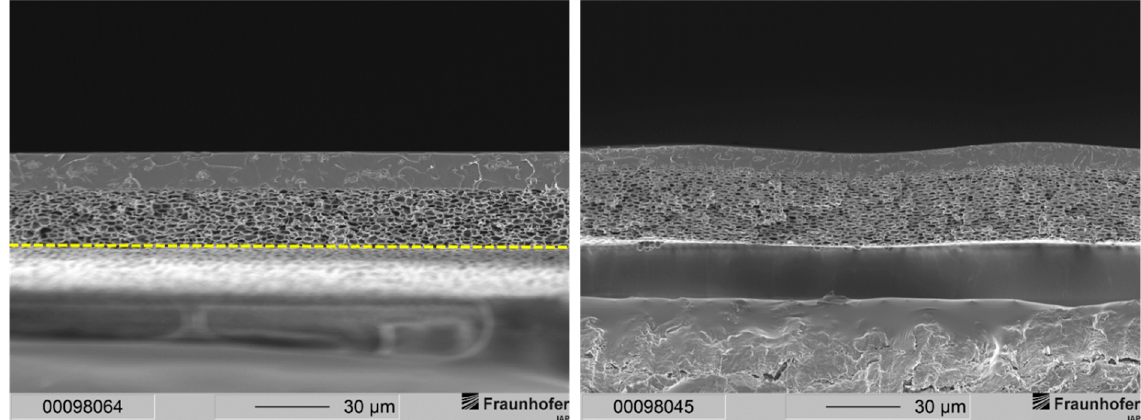
Figure 2. Cross-sections of layered PSU flat sheet membranes without PDMS protective layer. Left: precipitated in ethanol. Right: precipitated in distilled water [29]. The dashed line marks the bottom end of the cross-section of the membrane.